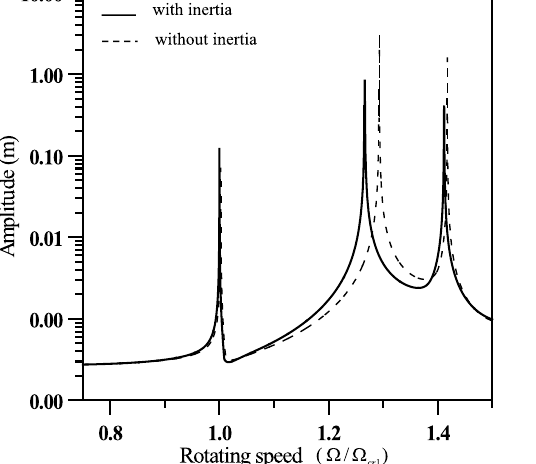
Fig. 5. Critical speed of rotor with and without coupler’s inertia. Fig. 6. In fl uence of coupler linear stiffness on critical